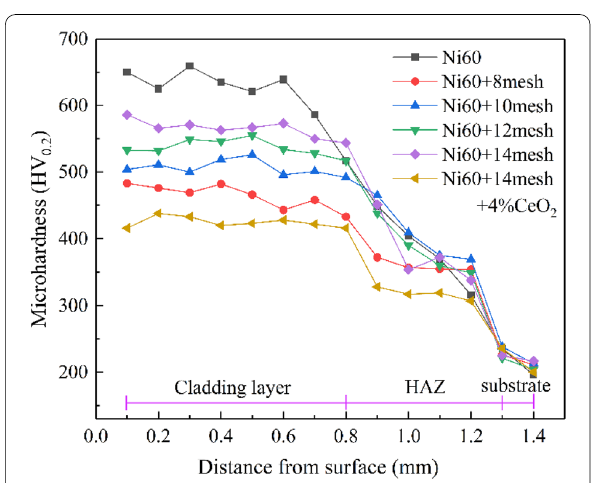
Figure 6 Microhardness of nickel-based compositions